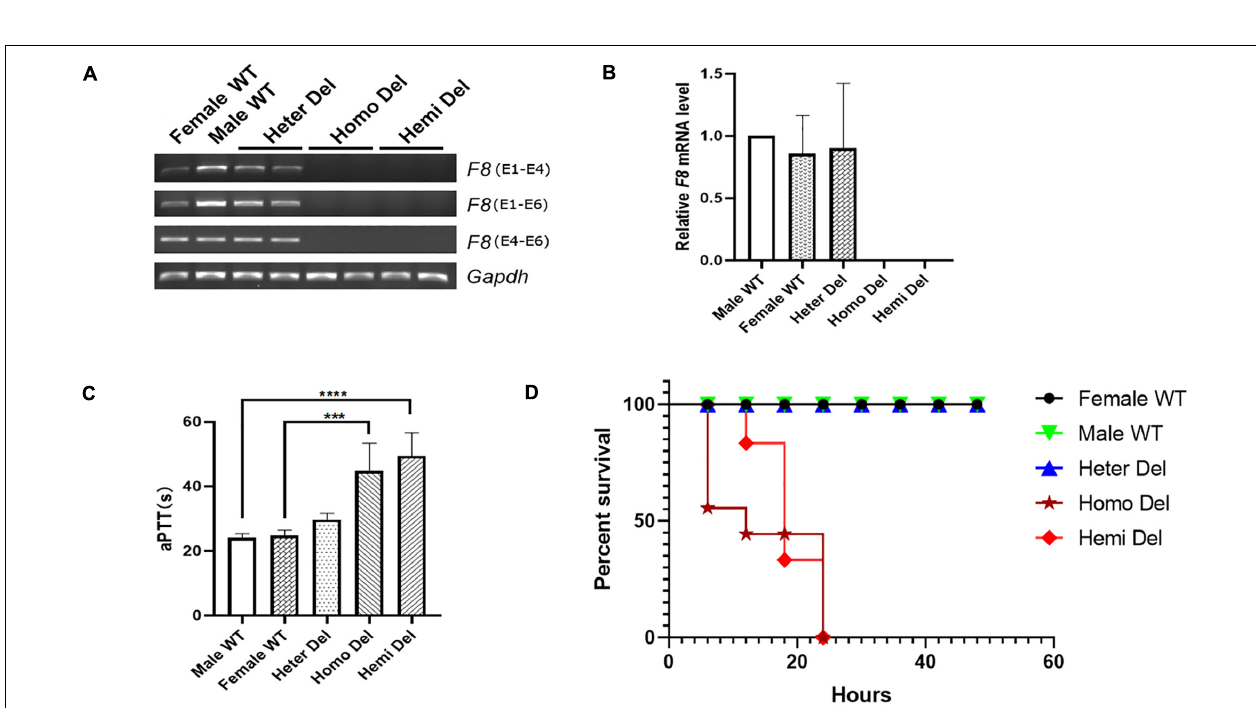
FIGURE 2 | Characterization of the HA mouse model. (A) RT-PCR analysis revealed that neither the transcripts cross the exon 1- 2 junction nor the exon 4–6 transcripts could be detected in the knockout mice. Gapdh was used as a loading control. (B) Expression levels of F8 mRNA in the hepatic tissue of indicated mice. (C) Measurement of coagulation activity by aPTT in mice at 2 months of age. (D) Survival rate of mice after tail clip challenge. The mice were monitored for 48 h after tail clipping. Male WT, n = 10; Heter Del, n = 10; Homo Del, n = 8; Hemi Del, n = 6. ∗∗∗ P < 0.001, ∗∗∗∗ P < 0.0001.